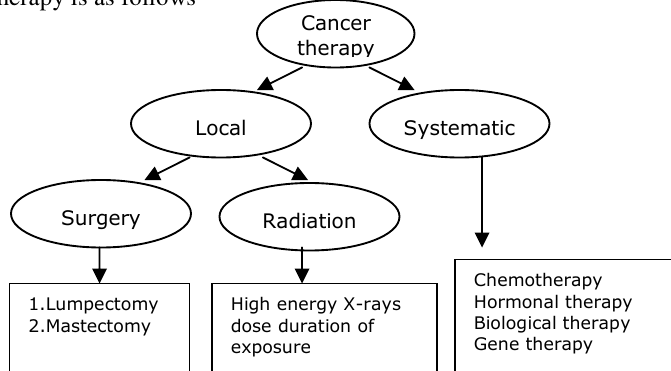
Figure 3 . Cancer therapy